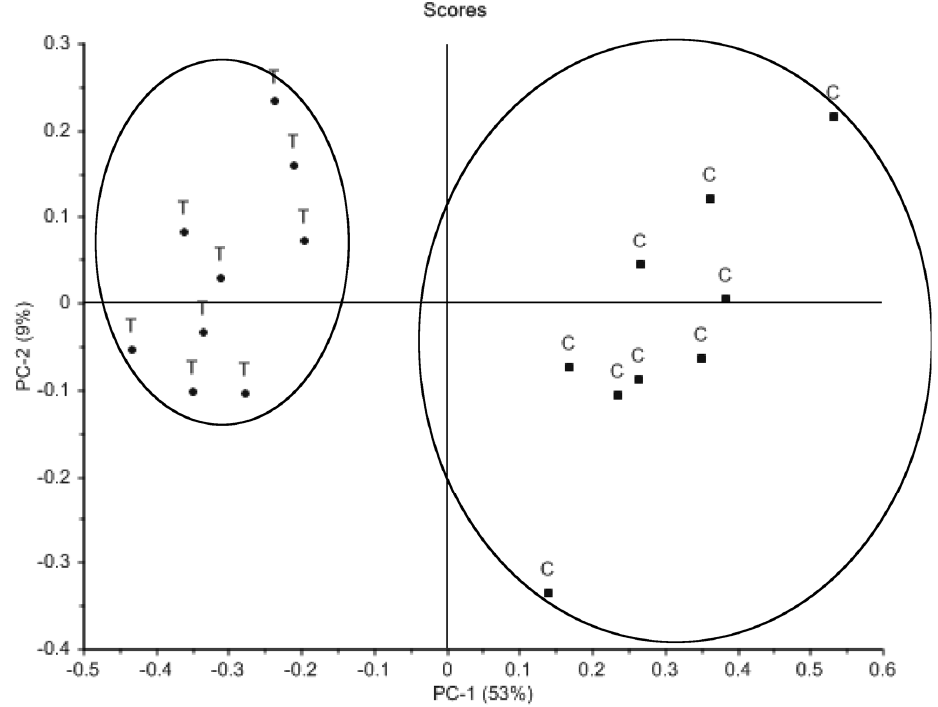
Figure 2. Principal component analysis scores plot of metabolite profiles generated by GC–MS analysis of rat B50 neuroblastoma cells (intracellular samples) untreated (C) (n = 9) or treated with 1 mM methamphetamine for 48 h (T) (n = 9).